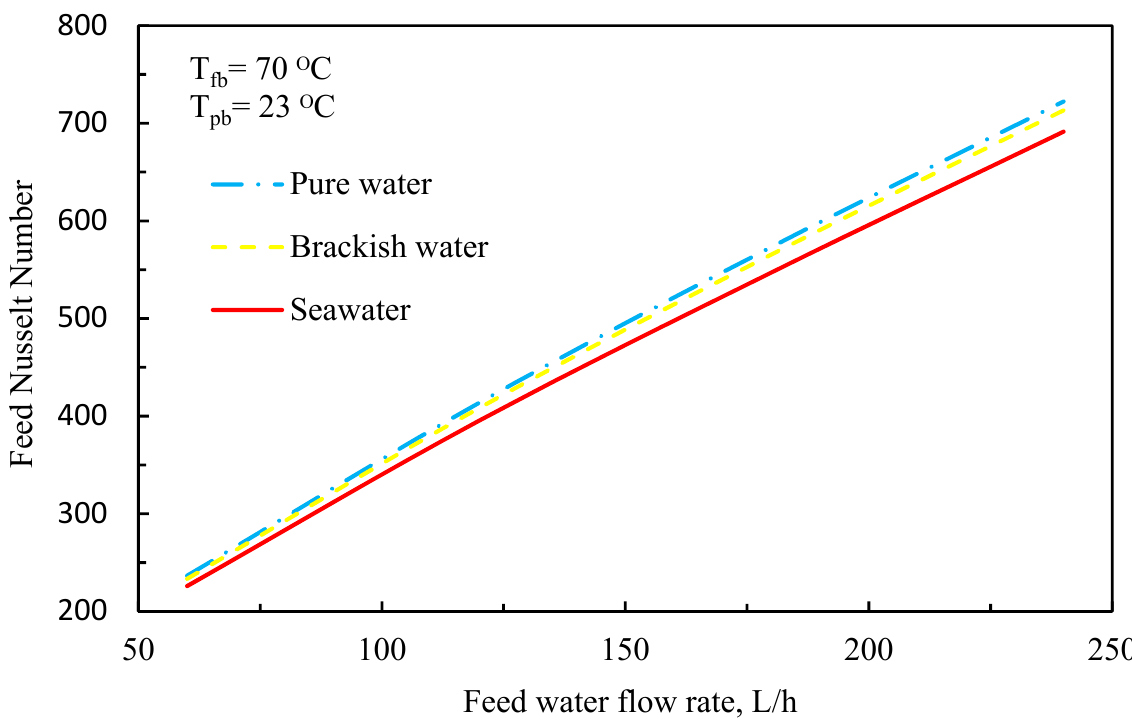
Figure 9. Feed Nusselt number versus feed water flow rate ( T fb = 70 °C, T pb = 23 °C).